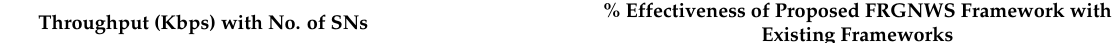
Table 6. The average % effectiveness of the proposed novel framework for the throughput metric with variations in the number of